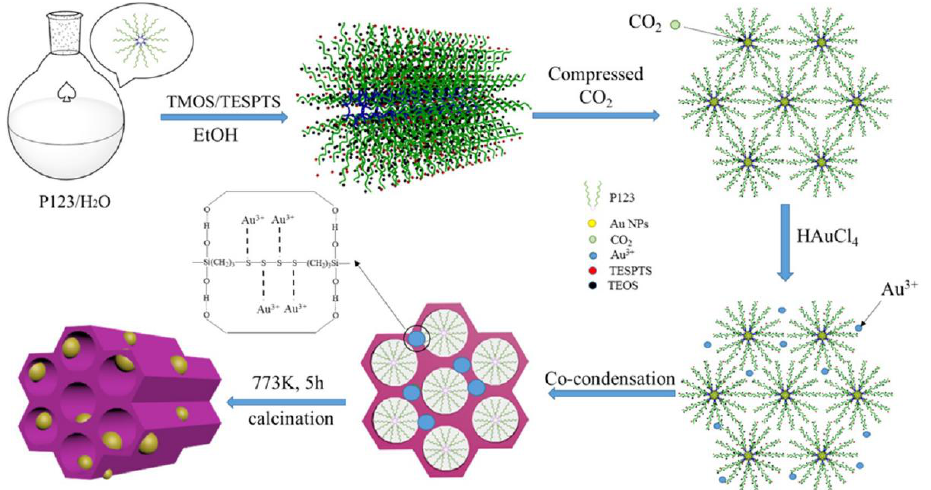
Figure 5. Schematic illustration of formation of the Au/mesoporous organosilicon composite with a one-pot approach. Reproduced with permission from Ref. [36]. Copyright 2018 American Chemical Society.